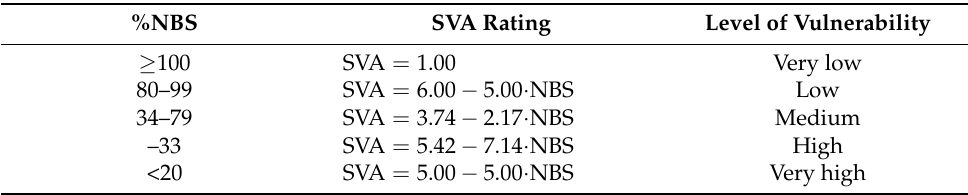
Table 8. Seismic vulnerability assessment